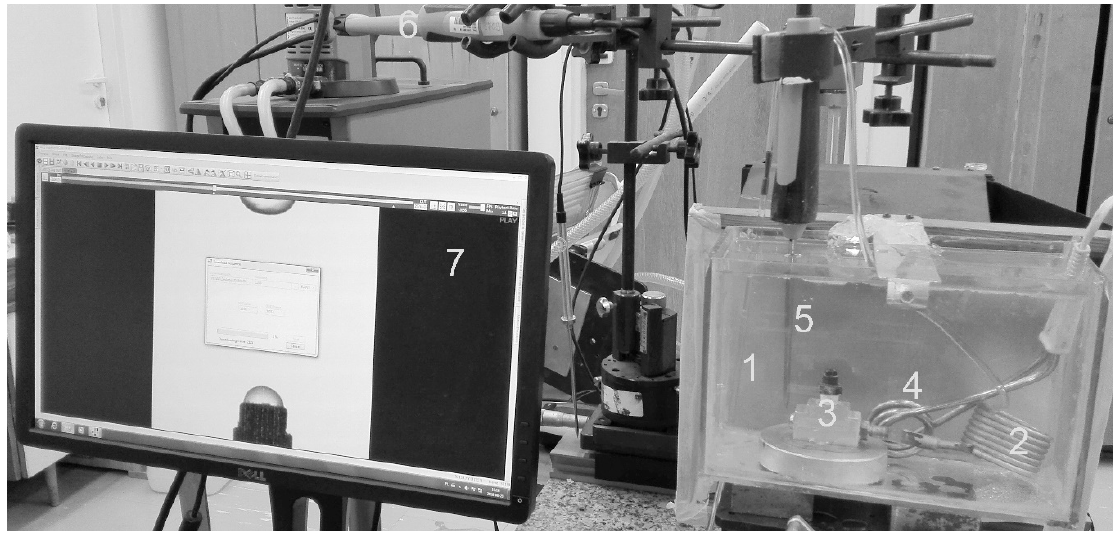
Figure 3. Air compressor (1a) and the plenum tank (1b).